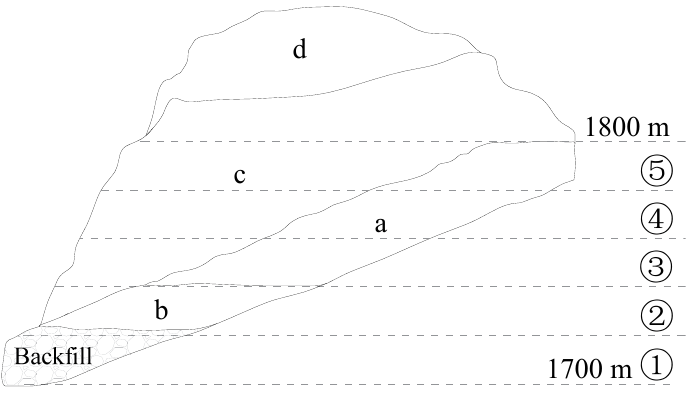
Figure 5. The evolution of the overlying strata caving.